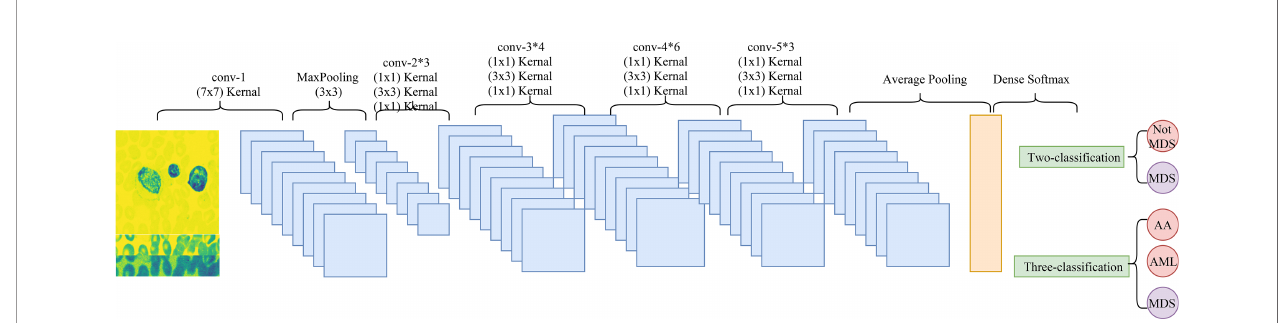
FIGURE 3 | The architectural details of Resnet 50.